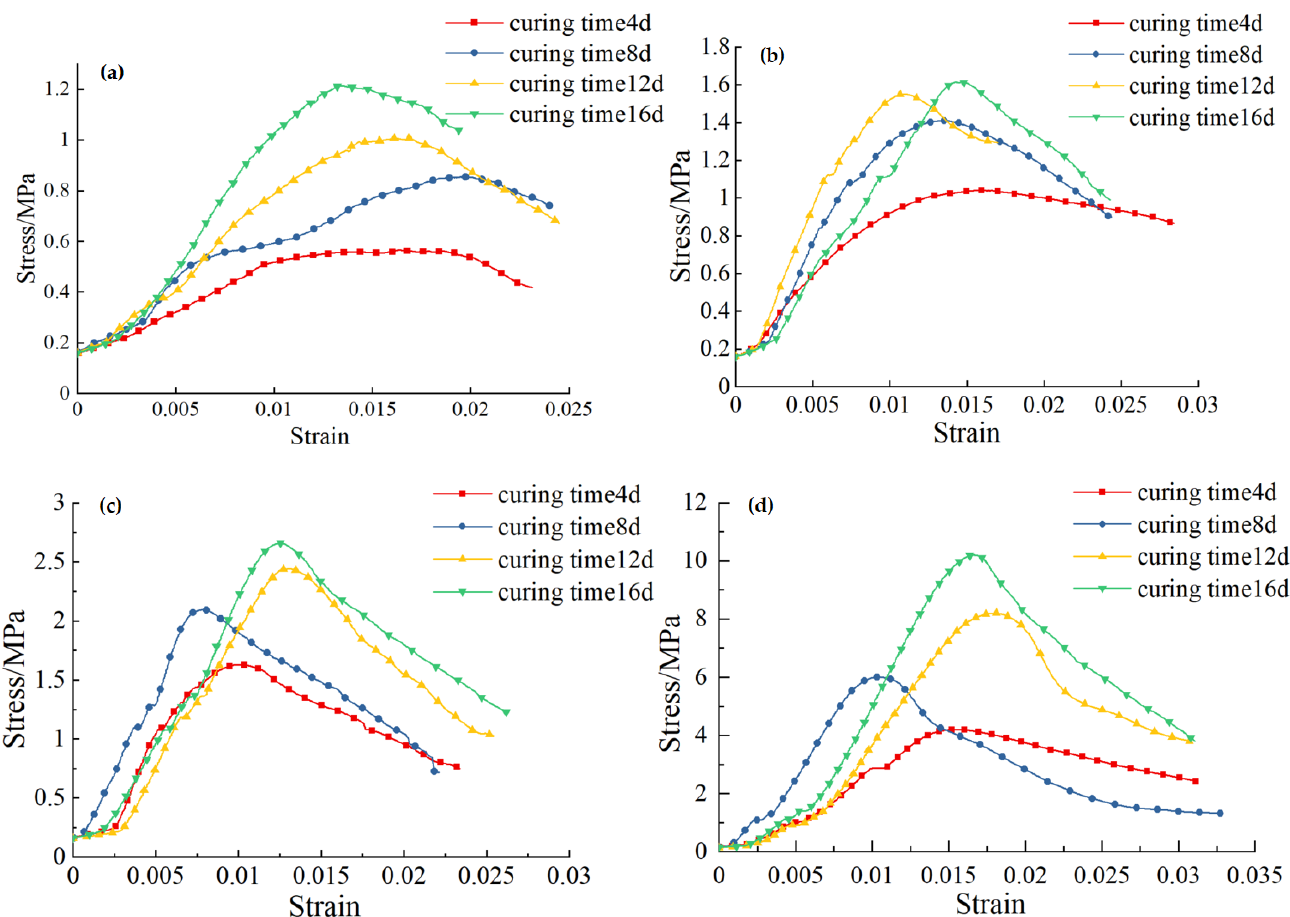
Figure 6. Complete stress–strain curves of gray brick under different curing methods. ( a ) Natural curing; ( b ) autoclave curing; ( c ) carbon dioxide curing; ( d ) autoclave–carbon dioxide curing. The uniaxial compressive strengths of the gray brick under different curing methods and curing ages are shown in Figure 7. The results indicate that, under autoclave curing, carbon dioxide curing and autoclave–carbon dioxide curing, the bearing strength of the gray brick increased to different degrees compared with that of natural curing. The uniaxial compressive strength of the gray brick under 16 days of natural curing was 1.25 MPa, while the uniaxial compressive strengths of gray brick under 16 days of autoclave curing, carbon dioxide curing and autoclave–carbon dioxide curing were 1.58 MPa, 2.58 MPa and 9.65 MPa, respectively, increasing by 26%, 98% and 668%, respectively, compared with natural